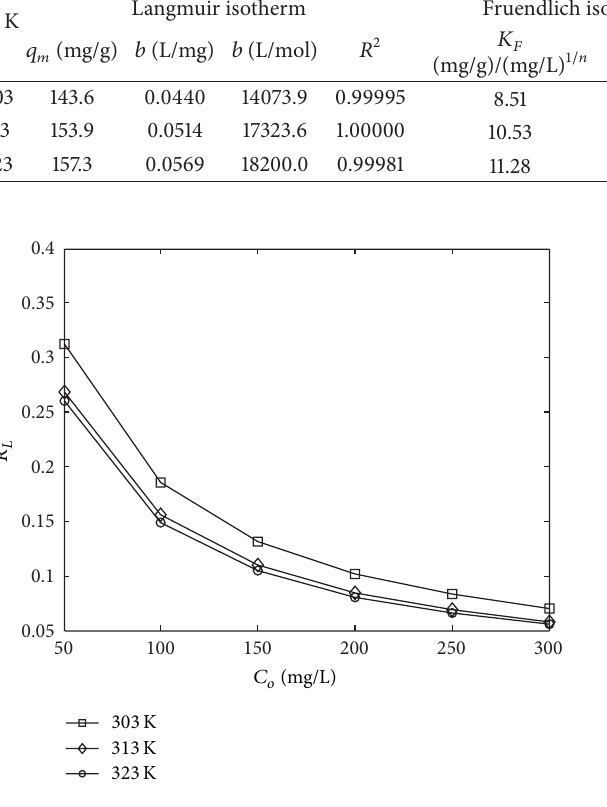
Figure 8: Separation factor 𝑅 𝐿 for MB onto palm male flower. Figure 9: Linearized Freundlich isotherm at different temperatures ( 𝑀 : 0.3 g; pH: 6; agitation rpm: 150).